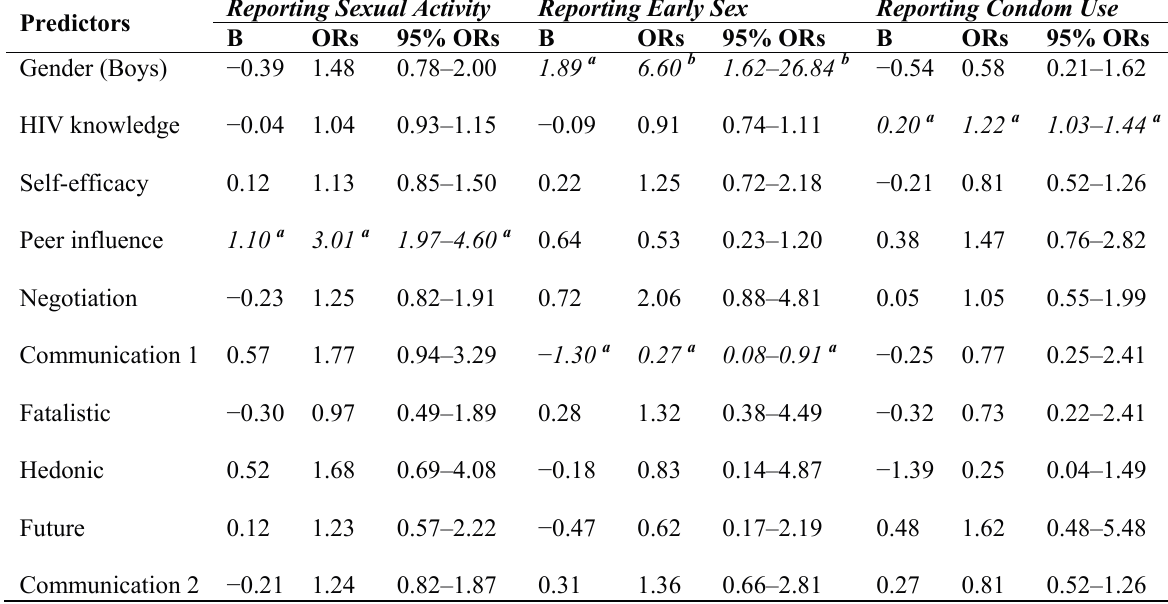
Table 5. Bivariate logistic regression of sexual